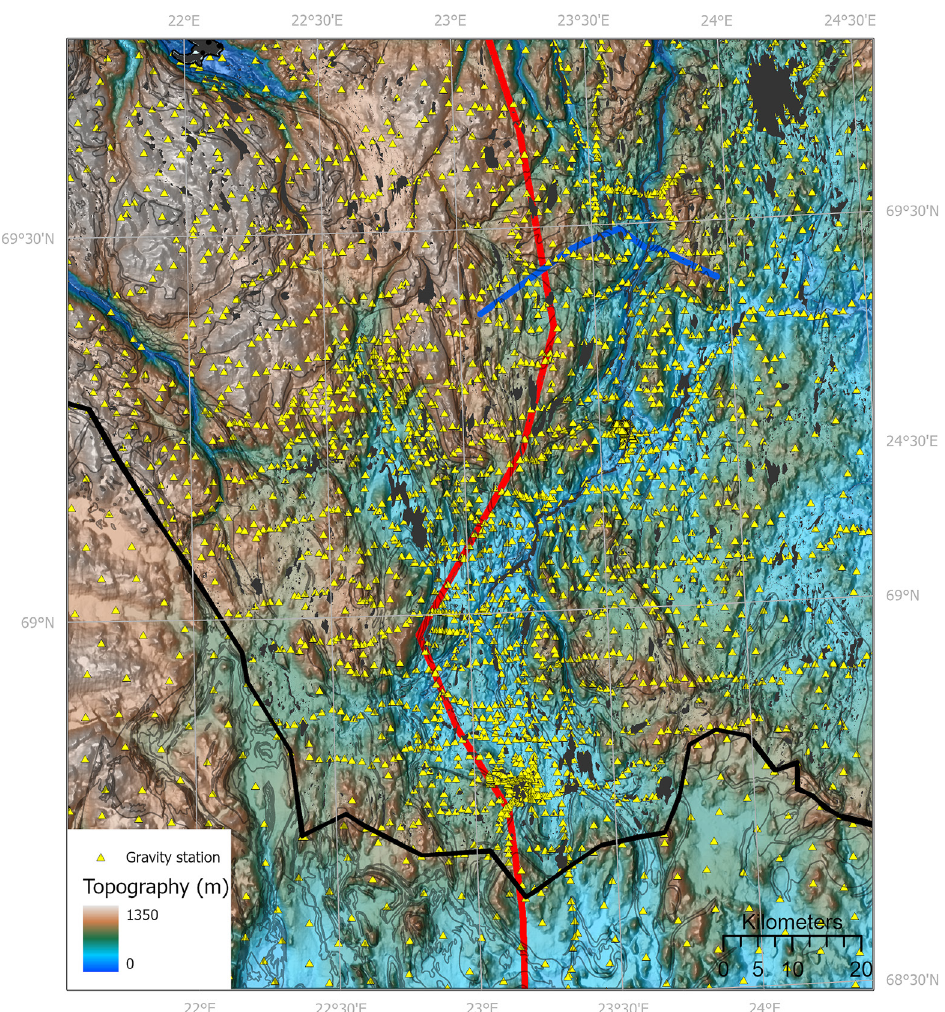
Figure 4. Topographic map of the study area (www.hoydedata.no). The measured gravity points are shown by the yellow triangles. The red line shows the FENNOLORA seismic line (Guggisberg et al., 1991), and blue line shows the Masi reflection seismic line (Mrope et al. 2019; Olesen et al. in press, Ruud et al.